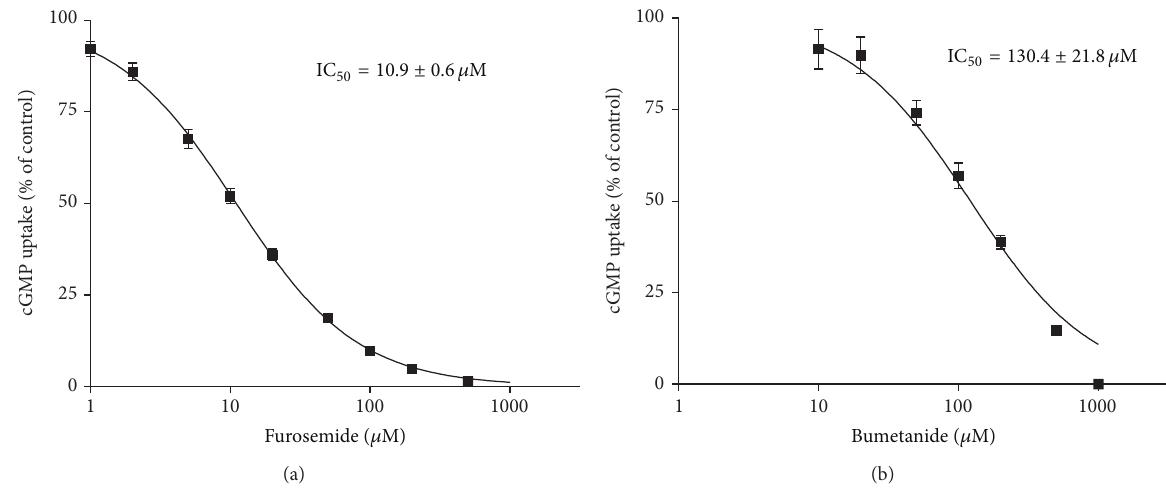
Figure 4: IC 50 determination for the inhibition of OAT2-mediated cGMP uptake by furosemide and bumetanide. In HEK293 cells stably transfected with OAT2 or empty vector, intracellular cGMP accumulation was determined after coincubation with 10 𝜇 M cGMP (0.1 𝜇 M [ 3 H ] cGMP + 9.9 𝜇 M unlabeled cGMP) and 1–1000 𝜇 M furosemide (a) or 10–1000 𝜇 M bumetanide (b), respectively, for 5 min at 37 ∘ C. The furosemide and bumetanide concentrations causing half-maximal inhibitory effect (IC 50 ) on cGMP accumulation in OAT2 expressing cells = 2 – 4 ; 𝑛 = 2 were calculated. Data are presented as mean ± SEM. 𝑛 furosemide bumetanide